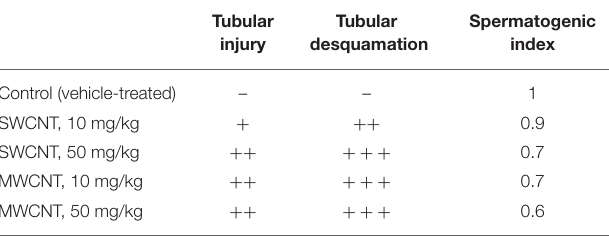
TABLE 1 | Histopathological alterations in CNTs-treated mice.